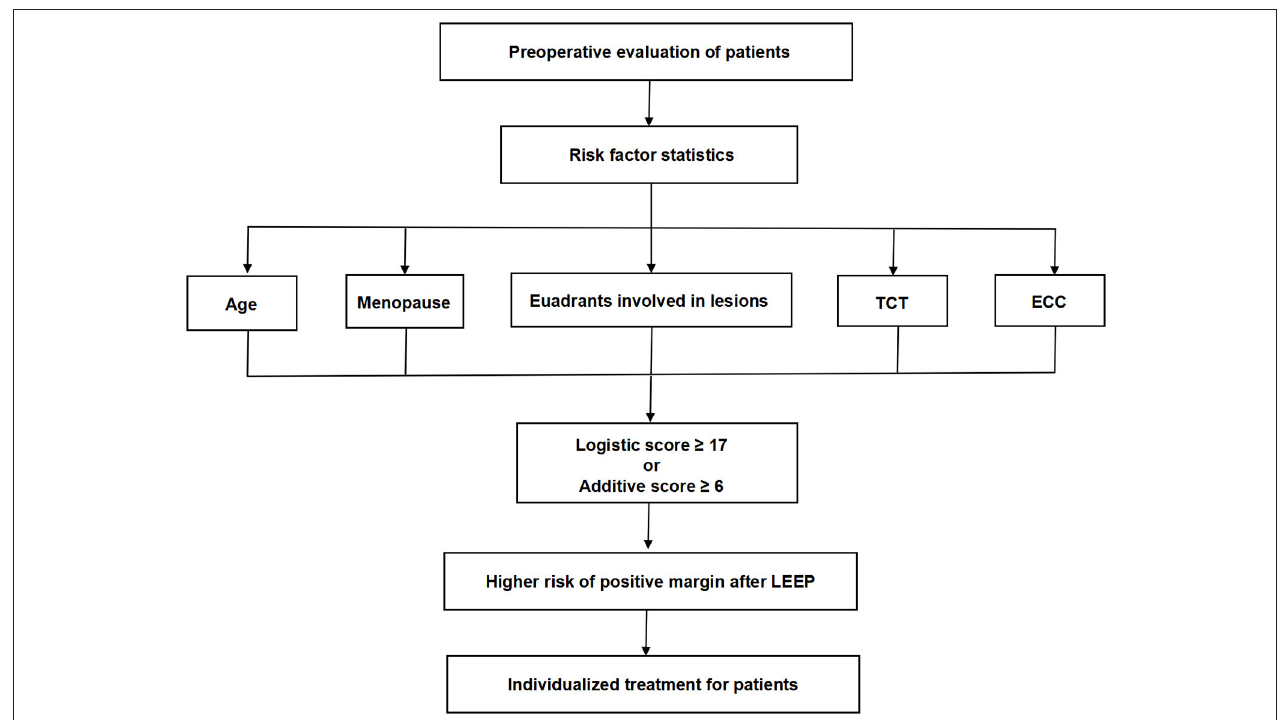
FIGURE 4 | Application process of the scoring system for preoperative